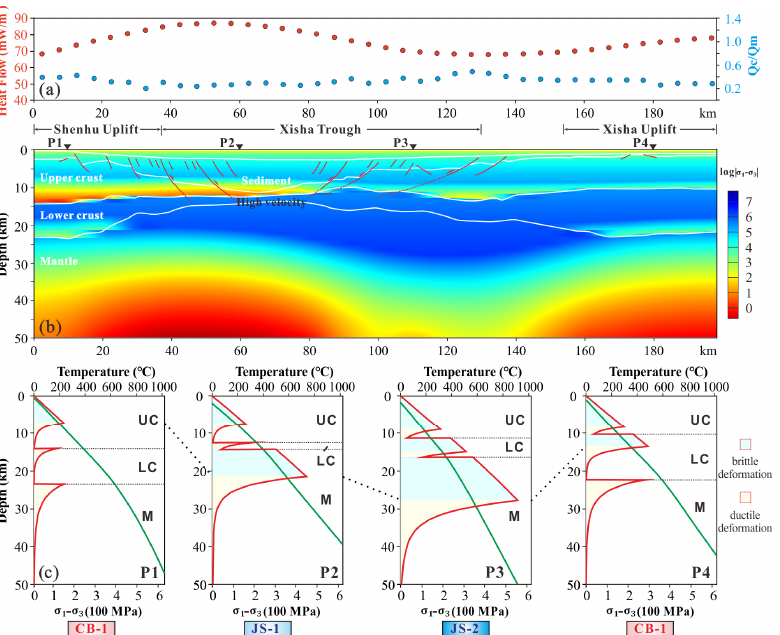
Figure 7. ( a ) The values of Q c /Q m and surface heat flow are represented by the blue points and red points, respectively. ( b ) The constructed lithospheric rheological structure of profile L1. ( c ) The thermo ‐ rheological models estimated at the typical locations of P1 − P4. Green and red lines denote the geothermal curve and yield stress envelope (YSE), respectively. The classical rheological models of JS − 1, JS − 2, and CB − 1 were recognized along profile L1 by the light blue, dark blue, and pink rectangles, respectively. JS − 1, jelly sandwich regime with weak lower crust; JS − 2, jelly sandwich regime with relatively strong lower crust; CB ‐ 1, crème brûlée regime with weak lower crust. Q c , crustal heat flow; Q m , mantle heat flow; UC, upper crust; LC, lower crust; M, upper mantle.